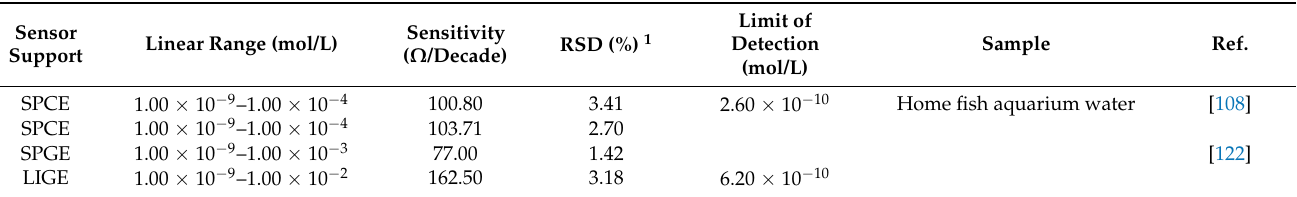
Table 2. Comparative performance characteristics of MIP(EBT) modified carbon-based sensors for EIS detection of CAP.